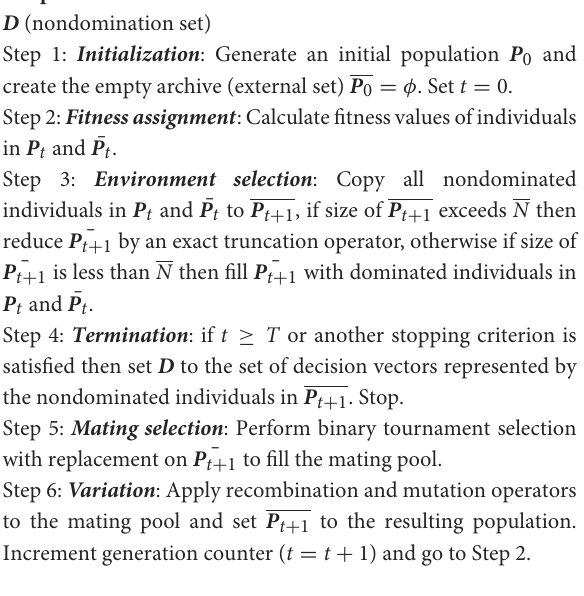
Algorithm 1. SPEA2